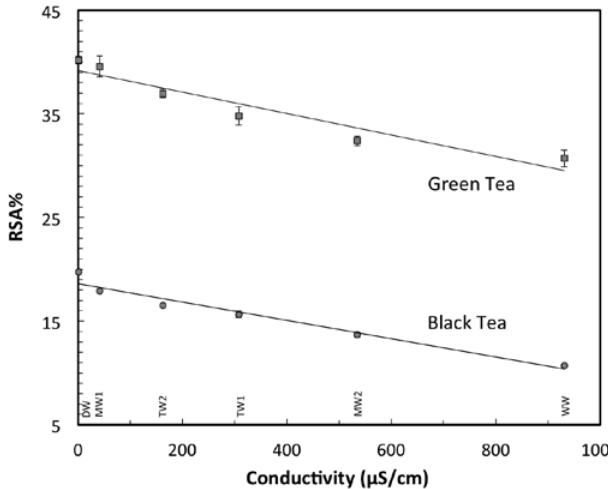
FIGURE 3 - Influence of water conductivity (µS/cm) on the radical scavenging activity